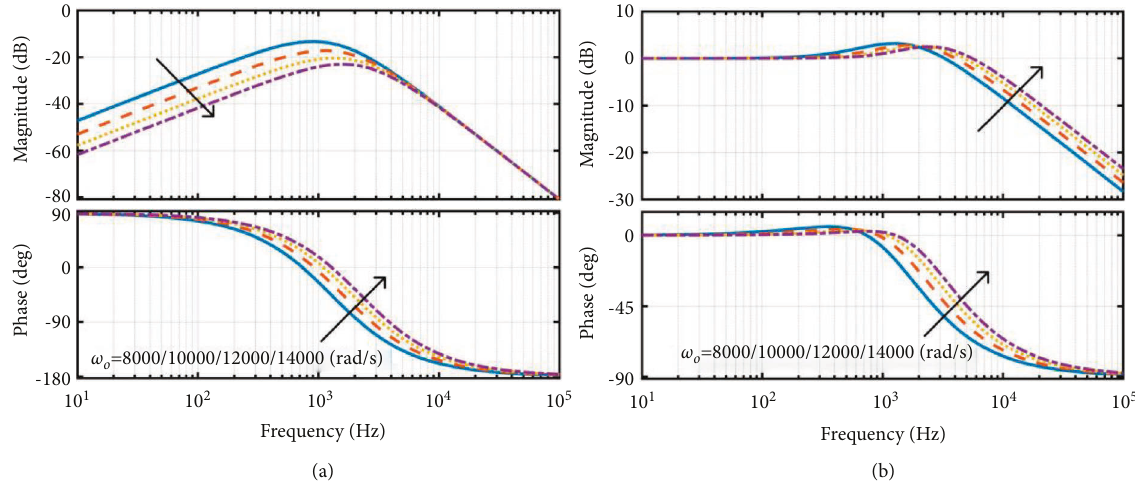
Figure 5: Phase-frequency characteristics of (a) 􏽢 x